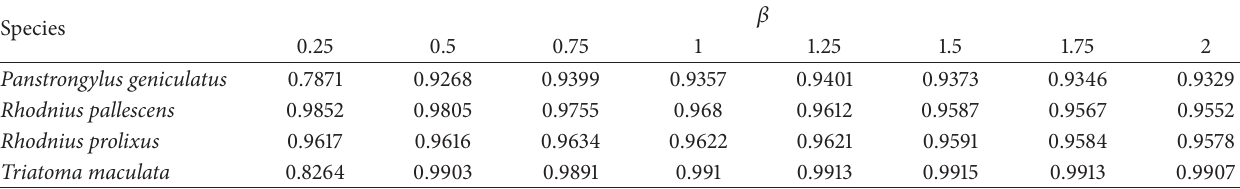
Table 2: AUC mean values calculated for each map with varying regularization 𝛽 parameter.